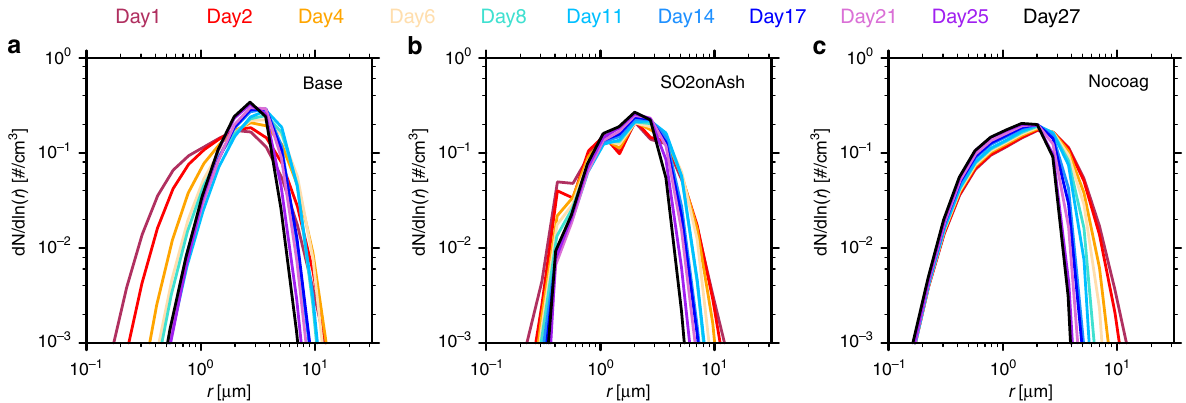
Fig. 5 The normalized mixed particle volume size distribution at 61 hPa. The normalized mixed particle volume size distribution at 61 hPa (19.5km) for the Base case, the SO2onAsh case, and the Nocoag case. The Nocoag case shows the simulation without coagulation between mixed particles and pure sulfates or between mixed particles and ash. The values are picked at the location with the largest mass mixing ratio of mixed particles on the days speci fi ed on top of the fi gure. The un-normalized distributions are shown in Supplementary Fig. 8.